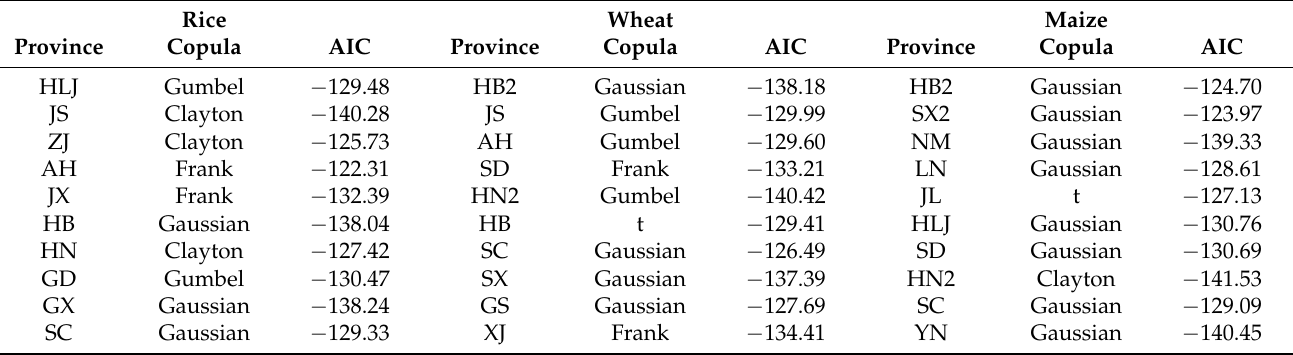
Table 4. Optimal copula for each crop and province during the reference period (1995–2014).